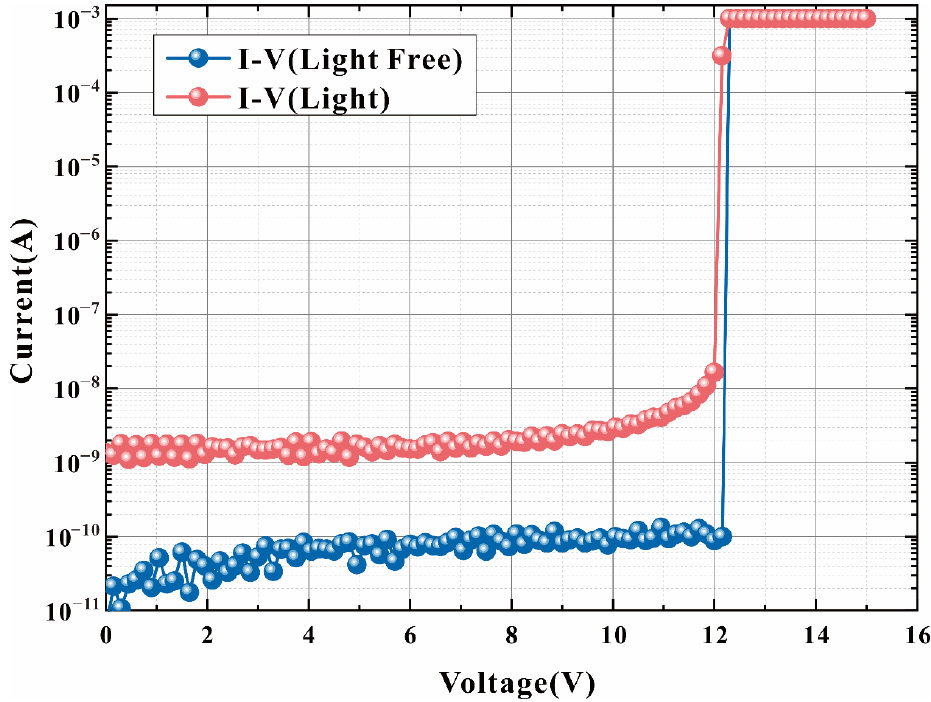
Figure 8. Measured I – V curve of HDEPD device (temperature: 20 °C).